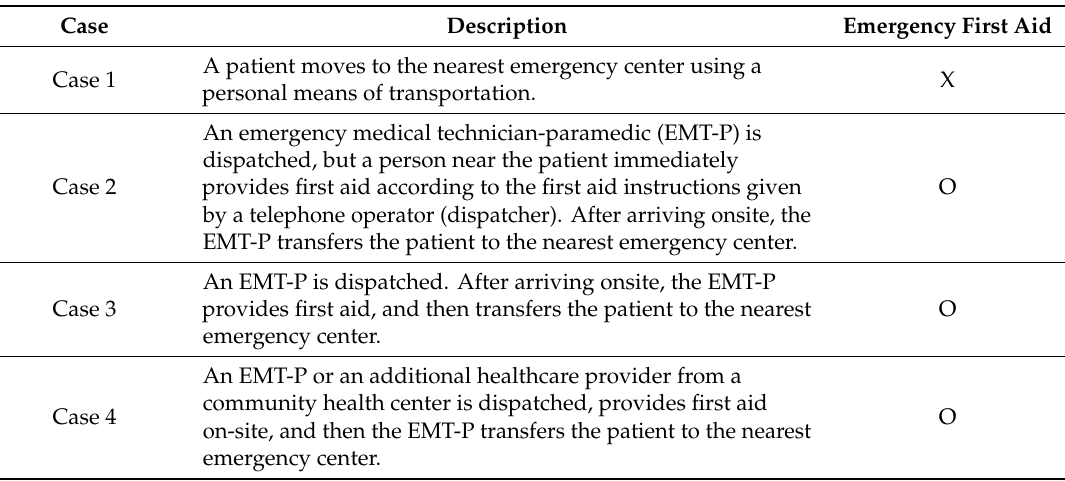
Table 2. Description of emergency cases considering first-aid and transfer